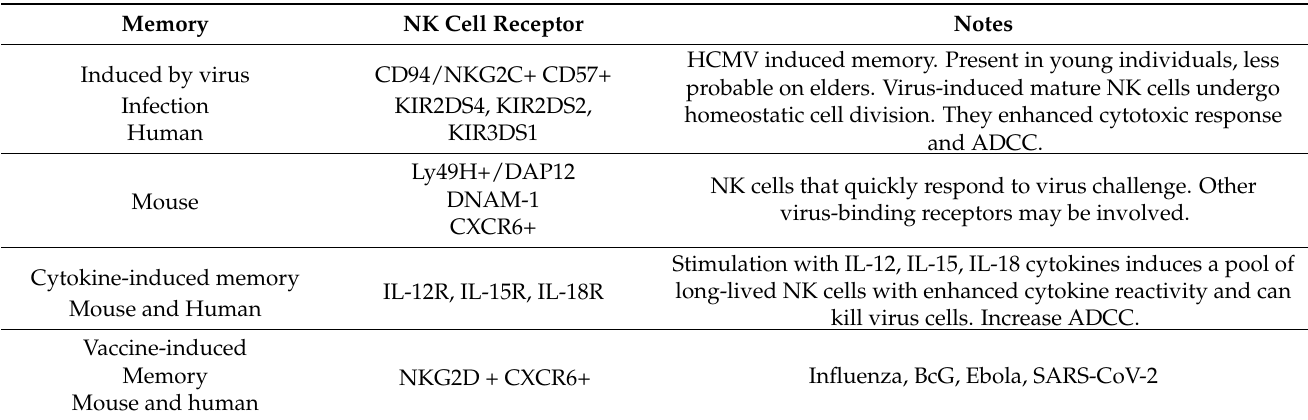
Table 4. NK receptors involved in different types of memory after viral